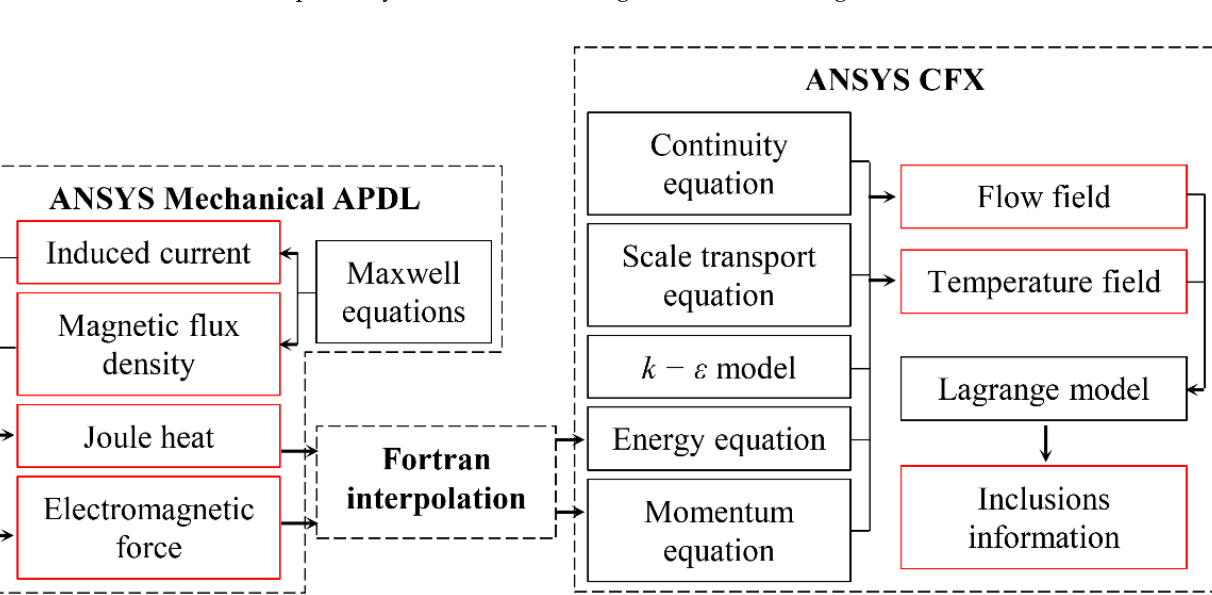
Figure 2. Calculation diagram.